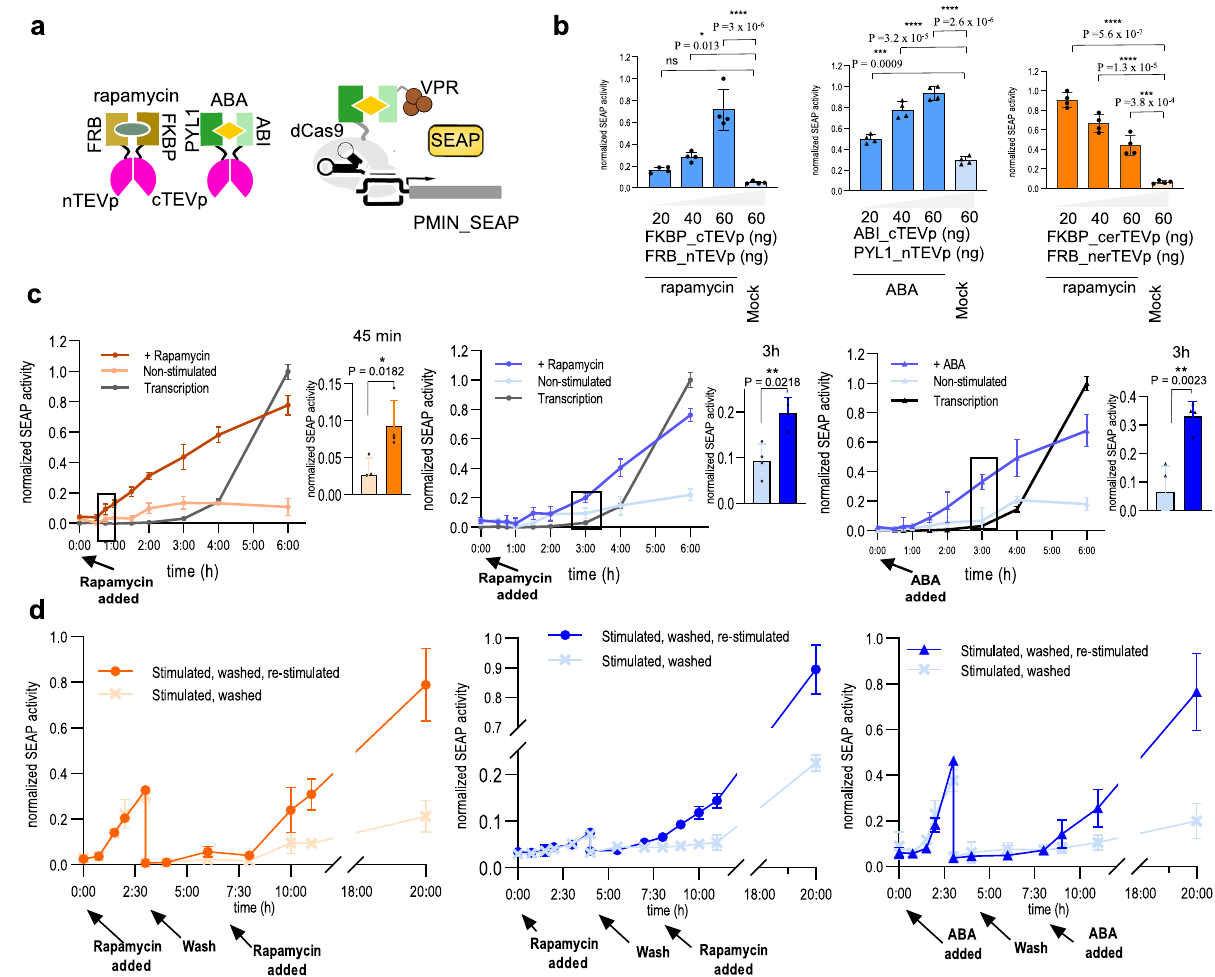
Fig. 2 Inducibility and kinetics of protein secretion. a For the inducible protein secretion, split protease fragments were fused to the chemically inducible dimerization partners FKBP/FRB or ABI/PYL1. For localization within the ER lumen, the inducible proteases were equipped with an N-terminal signal sequence and a C-terminal KDEL. Reconstitution of the protease was achieved by the addition of rapamycin in the case of FKBP/FRB or ABA in the case of ABI/PYL1. To compare the kinetics of secretion of our pre-synthesized proteins with secretion initiated by SEAP expression, a dCas9-FKBP/FRB-VPR or dCas9-ABI/PYL1-VPR system with an addition of an sgRNA targeting a minimal promotor upstream of the SEAP reporter gene, was utilized, where expression of SEAP was initiated by either rapamycin or ABA, respectively. b Cells were transfected with SEAP-TEVs-KDEL and FKBP-cerTEVp/FRB- nerTEVp (er-rapa-TEVp; orange), SEAP-FURs-TM-TEVs-KKYL and FKBP-cTEVp/FRB-nTEVp (rapa-TEVp) or ABI-cTEV/PYL-nTEV (aba-TEVp) (blue). SEAP activity was measured in the media after 20 h after the addition of rapamycin or ABA. c Secretion of SEAP was monitored after the addition of rapamycin for the lumER (orange) and rapamycin or ABA for the membER (blue) system and compared to the expression-driven secretion. d Secretion was induced by the addition of rapamycin or ABA. After 4 h, the medium was removed, the cells were washed and supplementary medium was added. After an additional 3 h cells were restimulated. SEAP activity in the media was measured continuously. Values are the mean of four cell culture experiments ± s.d. Signi fi cance was tested by an unpaired two-tailed t test or one-way analysis of variance (ANOVA) with Dunnett ’ s comparison (values of con fi dence intervals, degrees of freedom, F and P are indicated). Results are representative of three ( b , c ) and two ( d ) independent experiments. * P <